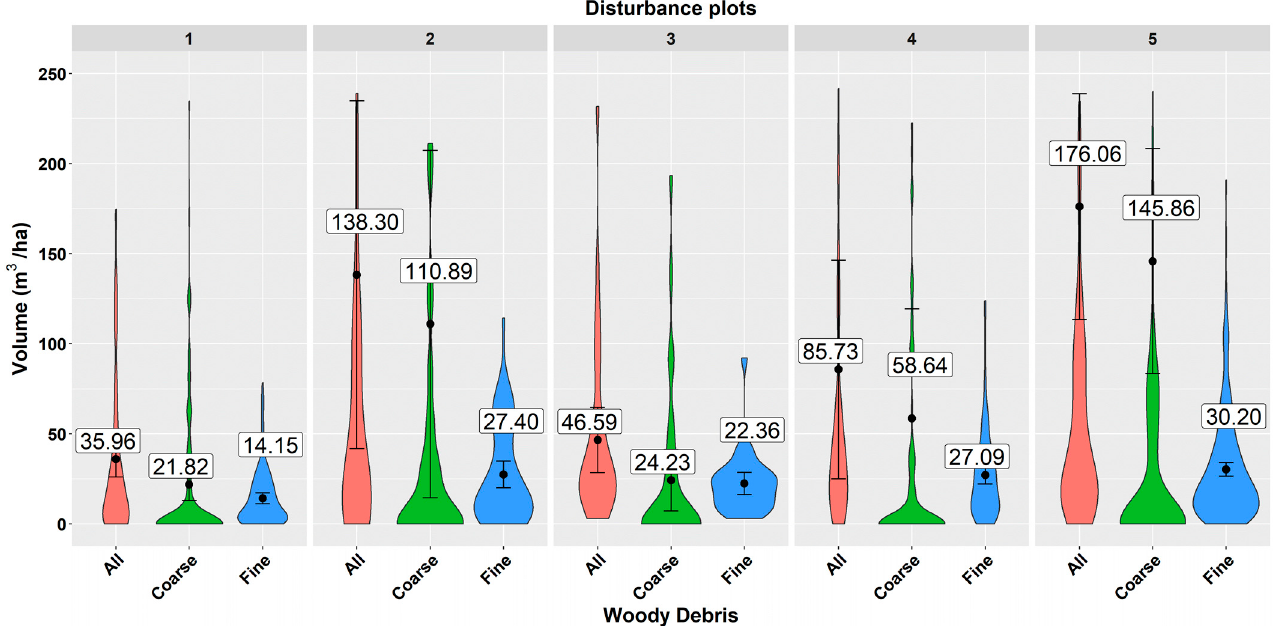
Figure 1. Deadwood volume at individual disturbed areas. A violin plot depicts distributions of numeric data using density curves. The width of each curve corresponds with the approximate frequency of data points in each region. The black point and the value represent the mean deadwood volume and the error bar shows a 95% confidence interval of the mean.